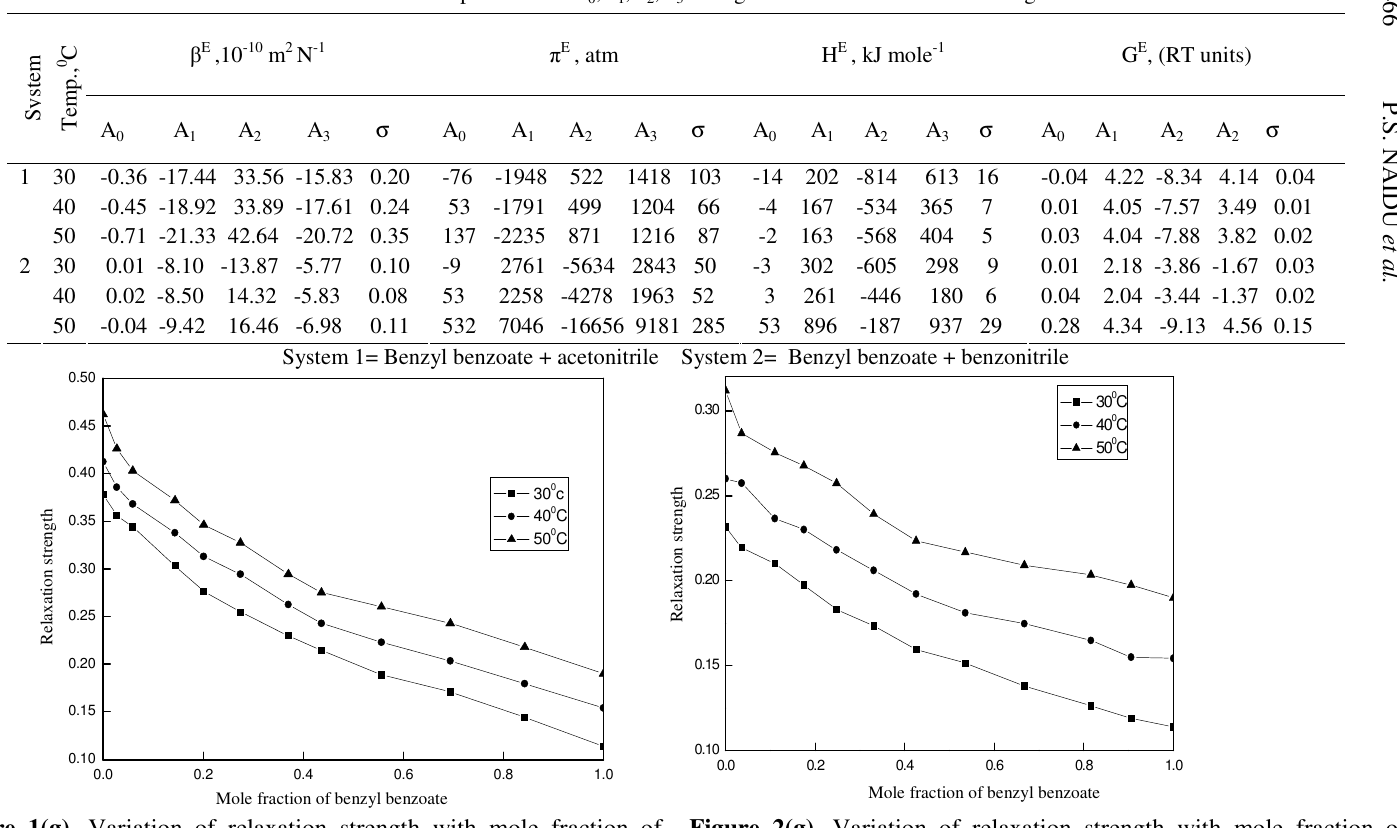
Table 5 . Various parameters- A 0 ,A 1 ,A 2 ,A 3 along with standard deviation σ using Redlich-kister method